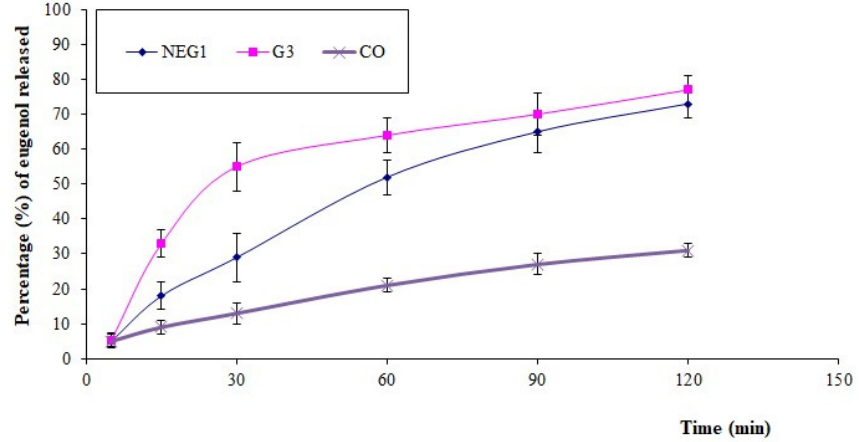
Figure 6. In vitro eugenol (marker molecule for CO) release from HPC hydrogel loaded with opti- optimized CO-NE (NEG1), aqueous dispersion of CO-NE without HPC gel base (G3), and pure